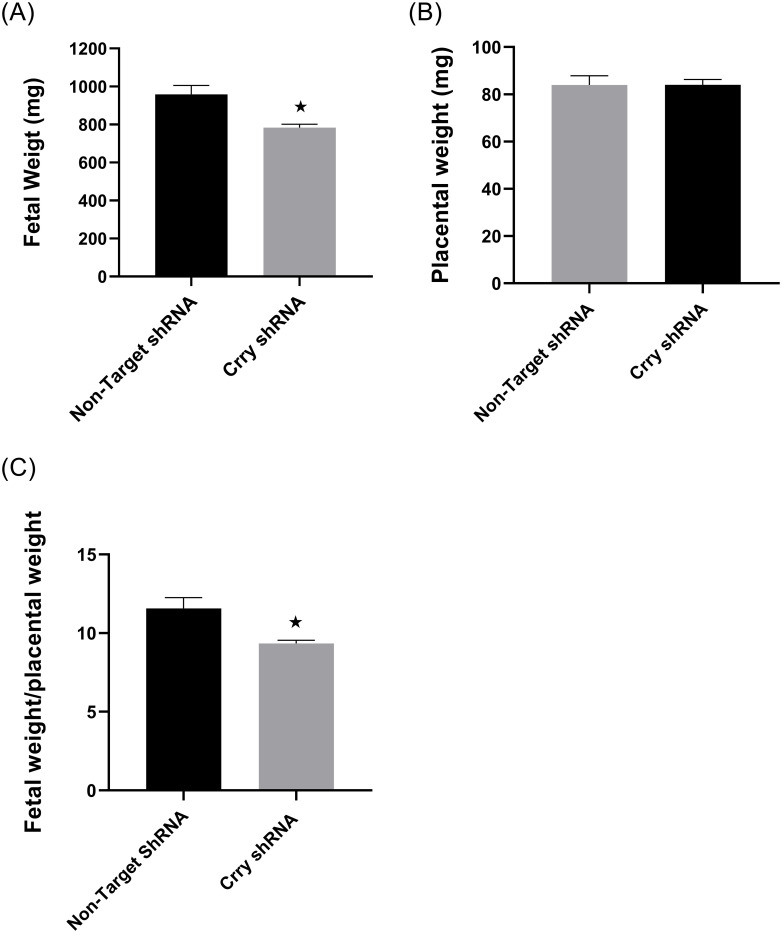
Decreased fetal weight in CrryshRNA mice.Fetal and placental weights were measured at 17.5 dpc soon after euthanasia (n = 5–7), A) Average fetal weight was significantly reduced (p = 0.048) in CrryshRNA mice compared to control group B) Average placental weight was not different between the two groups C) Fetal-placental weight ratio was significantly decreased (p = 0.045) in Crry shRNA mice compared to control mice.